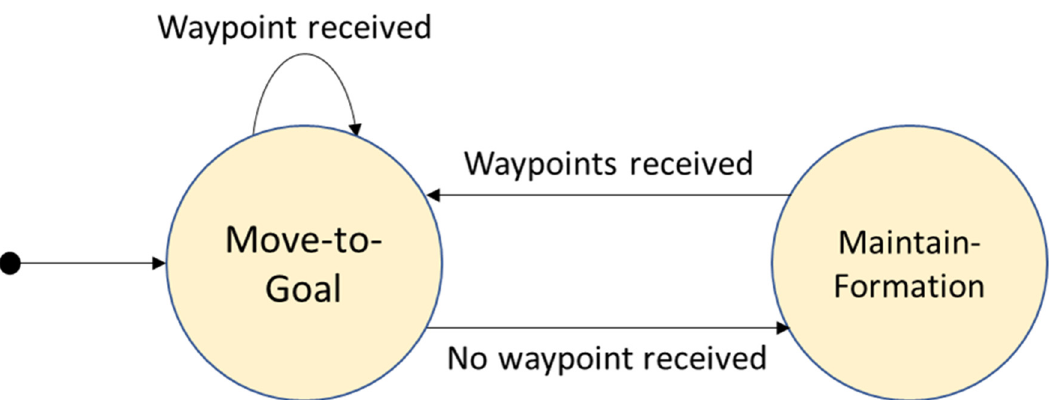
Figure 14. Architecture of the Follow-Leader-with-Jam-Mitigation assemblage.